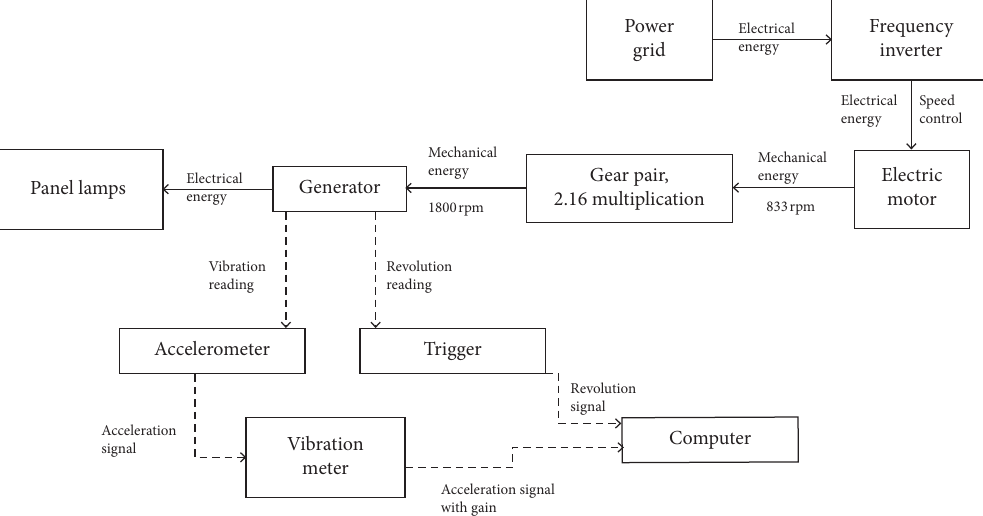
Figure 3: Schematic diagram of the workbench.